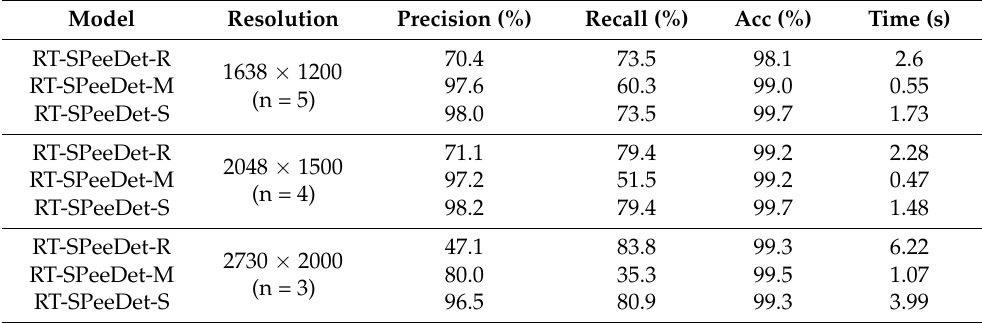
Table 4. Small pit defect detection test results according to input image resolution.